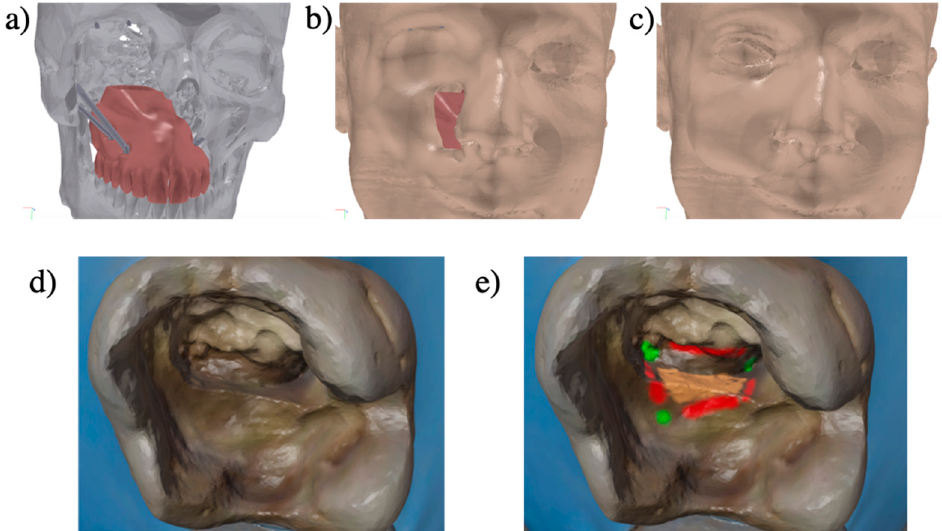
Figure 6. Two innovative activities using 3D files. 3D-PDF format could be used to offer simplified visualization of maxillofacial prosthetics concepts to dental students, by interacting with different volumes, or using preselected views ( a – c ). An incorrect 3D endodontic cavity ( d ) could be used to ask student to: -determine the root canal (green), -the form of the future endodontic access cavity (red) and the corrections to realize (orange), using 3D “painting” tools ( e ) (here using the Vertex paint mode of Blender).